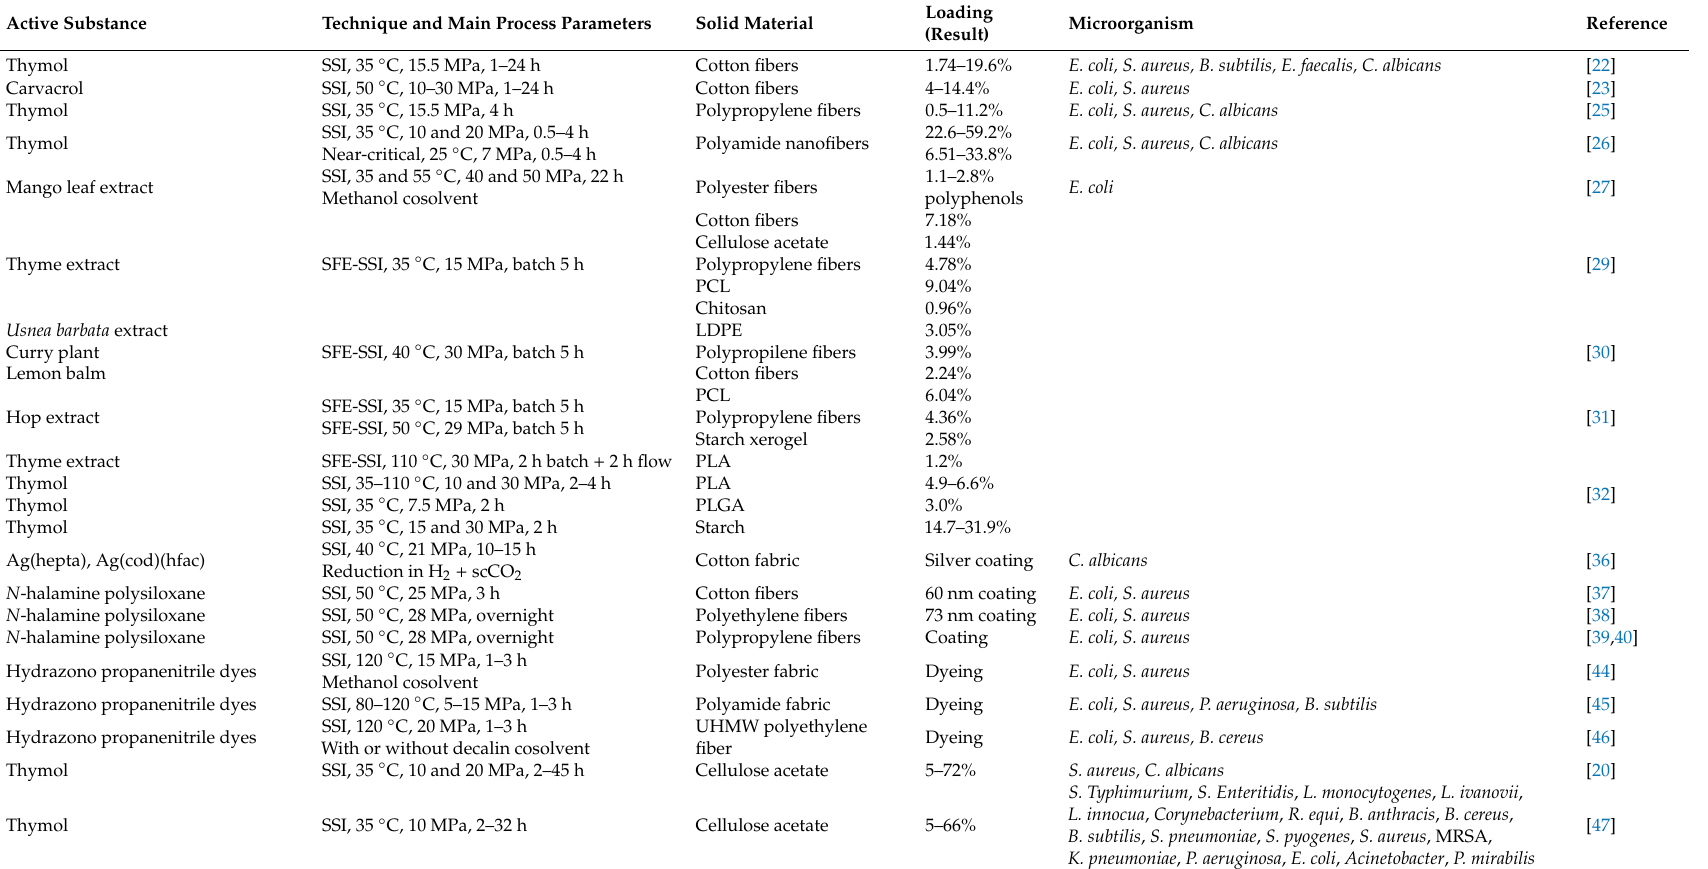
Table 1. Tabular presentation of cited